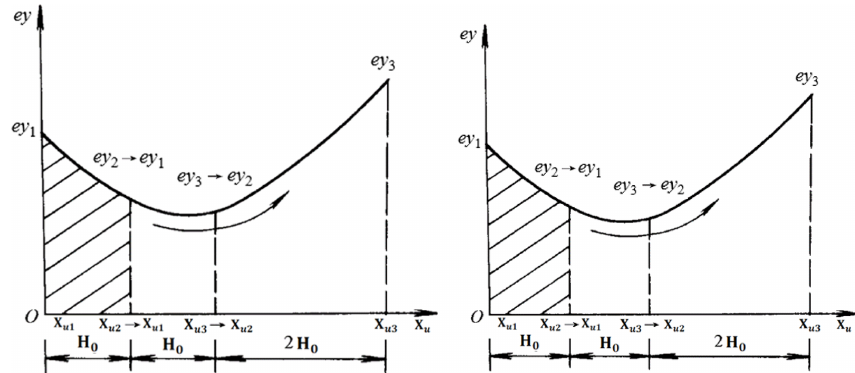
Figure 2. Schematic illustration of the advance and retreat